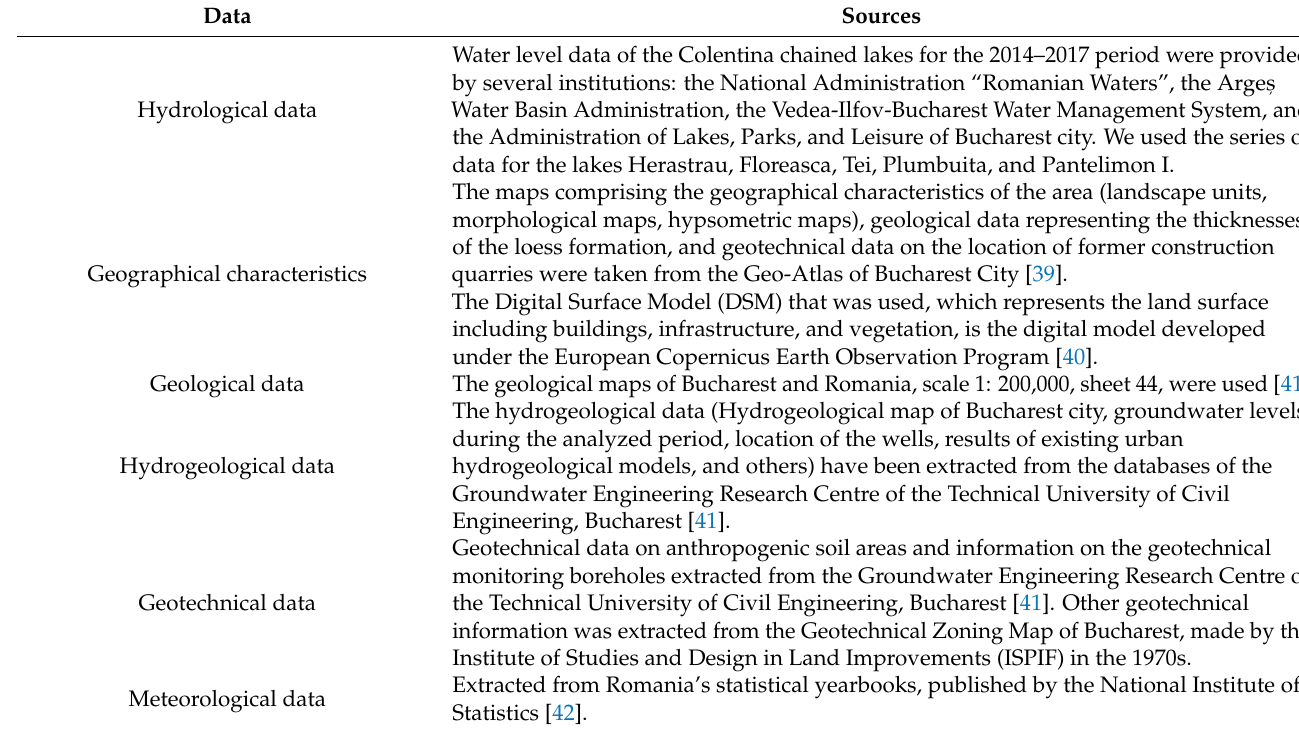
Table 3. Data types and sources (modified after